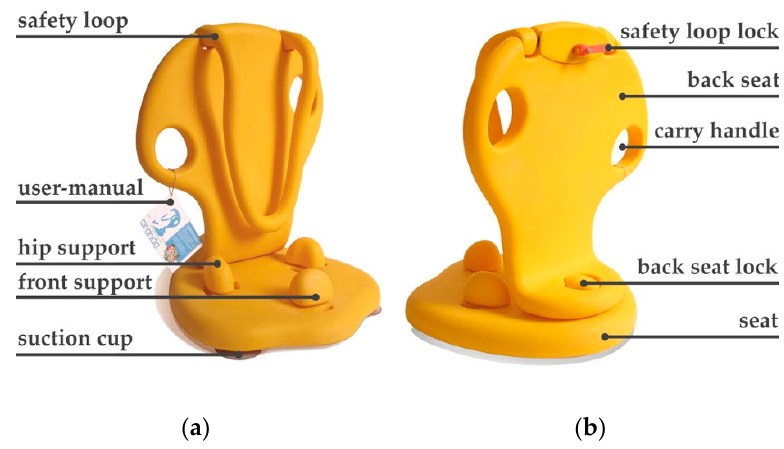
Figure 1. Salable Ciranda parts: ( a ) front of Ciranda seat, indicating the safety loop, user-manual, hip support, front support, and suction cup; ( b ) back of Ciranda seat, indicating the safety loop lock, back seat, carry handle, back seat lock, and seat.